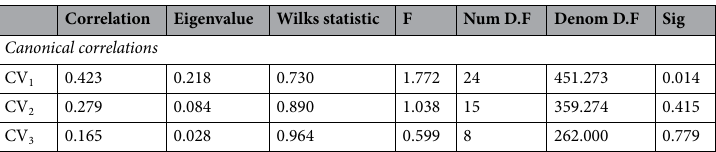
Table 3. Canonical correlations between the two sets of variables in Autumn. H 0 for Wilks test is that the correlations in the current and following rows are zero. The first canonical variable (CV 1 ) shows a significant correlation ( p = 0.021), while the other variables showed non-significant